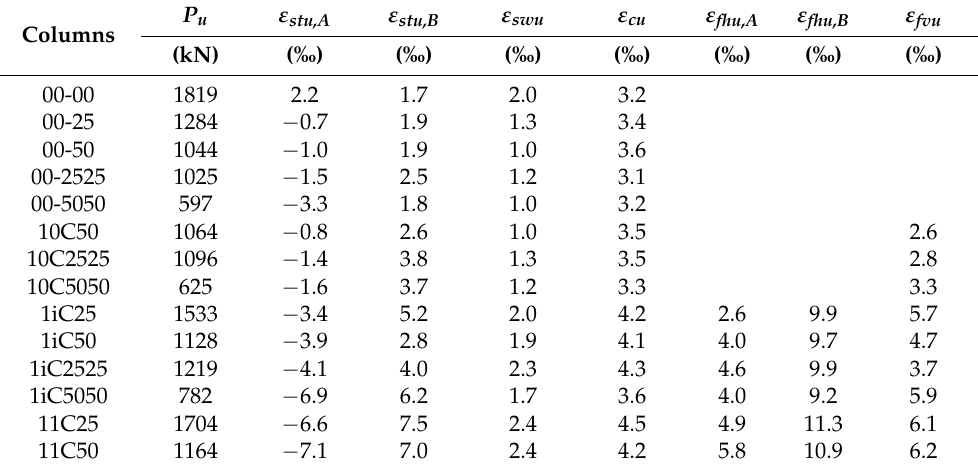
Table 4. Strains at ultimate